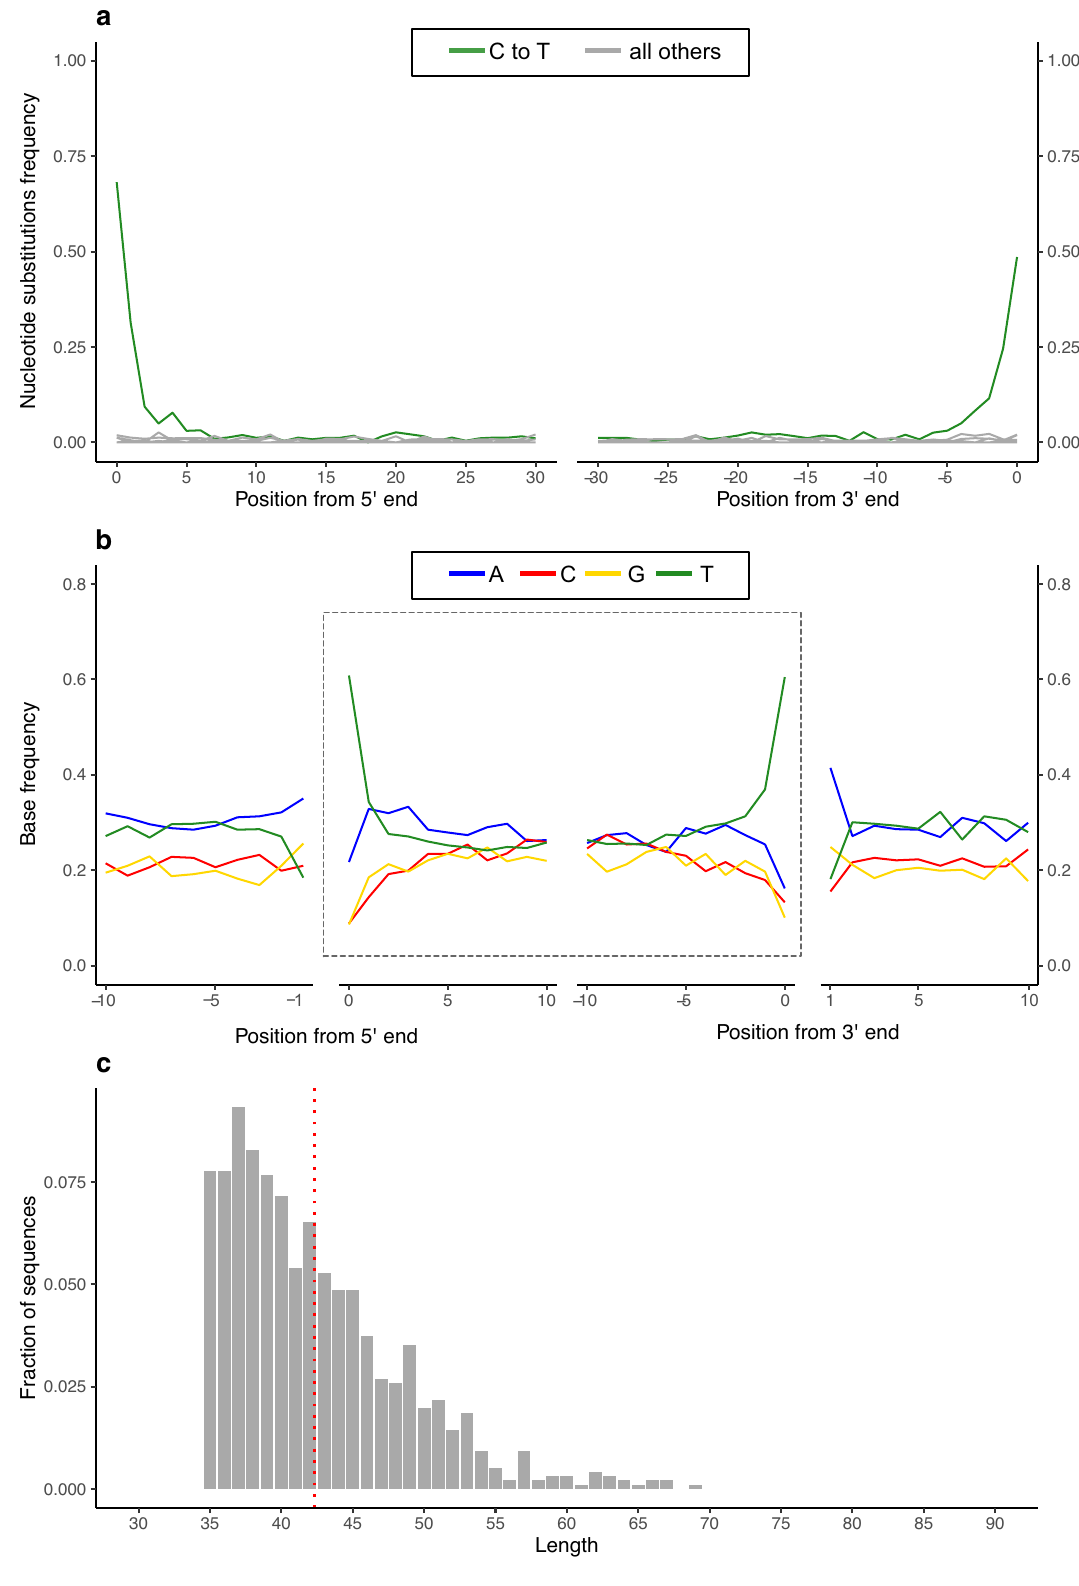
Figure 5. Authentication of the 982 mtDNA fragments assigned to Cervidae in sample SP5773 from Layer V. Following the alignment of the fragments to the Cervus elaphus reference mitochondrial genome and their filtering for a mapping quality of 25 or more, 965 fragments were retained for these analyses. ( a ) Frequency of nucleotide substitutions towards the starts and ends of fragments compared to the reference genome. ( b ) Base composition towards the start and end of the sequenced DNA fragments (within dashed gray outline) and of the reference genome upstream and downstream from fragments’ ends. ( c ) Length distribution (in bp) of the Cervidae mtDNA fragments. The average length is shown by the red dashed